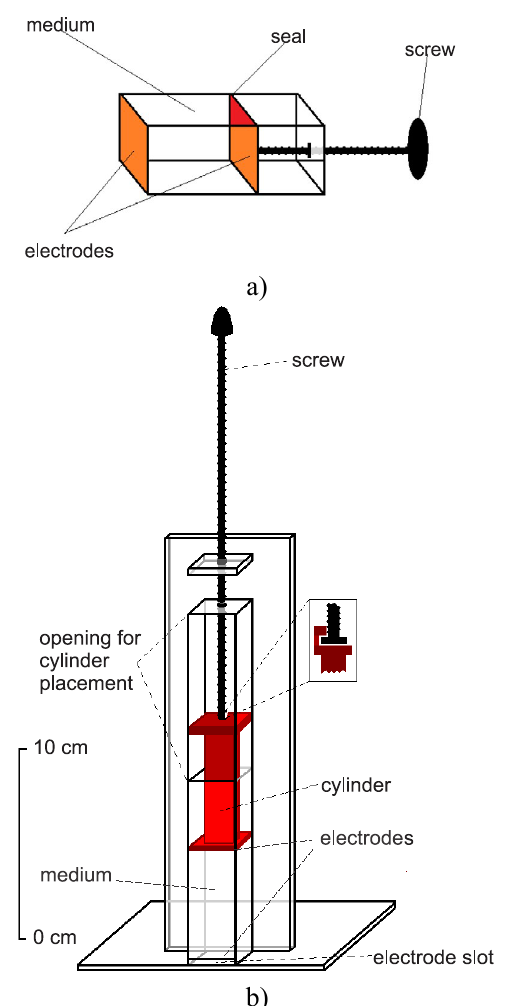
Fig. 1: a) simplified view of the measurement cell, b) complete measurement setup.